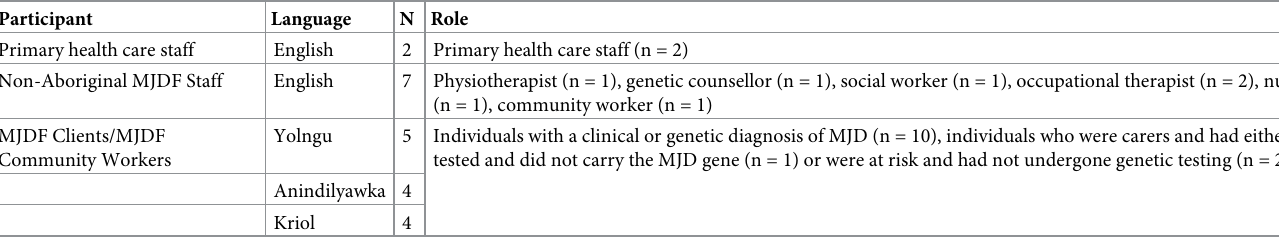
Table 1. Interview